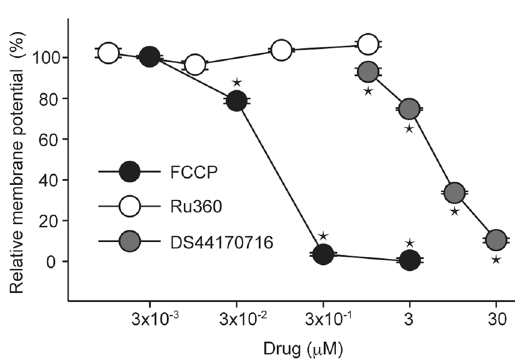
Figure 5. DS44170716 decreases mitochondrial membrane potential in isolated mitochondria from pig heart. Relative membrane potential 0% or 100% was defined as 3 μ M FCCP data or vehicle data, respectively. Data obtained from 4 independent samples are shown as the mean with SEM. Asterisk shows P < 0.05 compared to vehicle group (Dunnett’s